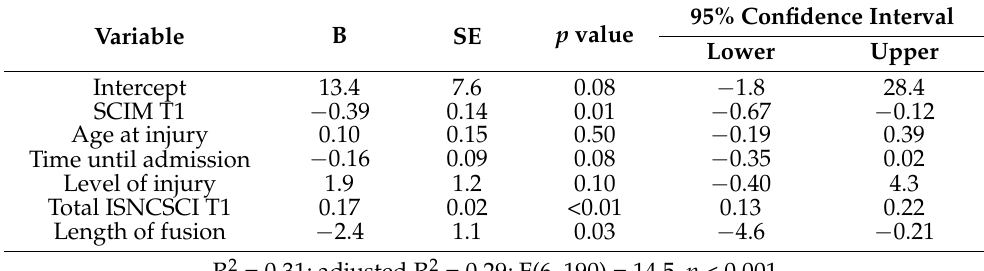
Table 6. Multiple linear regression analysis of the SCIM difference.